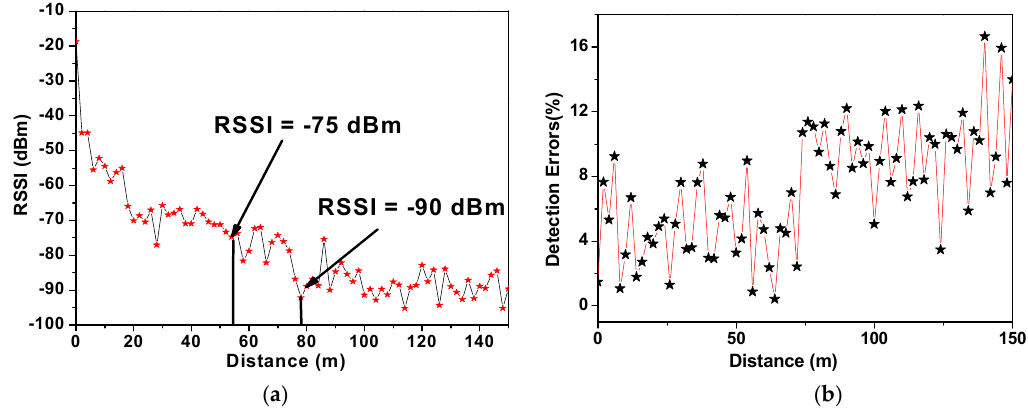
Figure 14. ( a ) The measured RSSI with increasing communication distance in a greenhouse; ( b ) the detection error of measured RSSI with the increasing communication distance in a greenhouse.